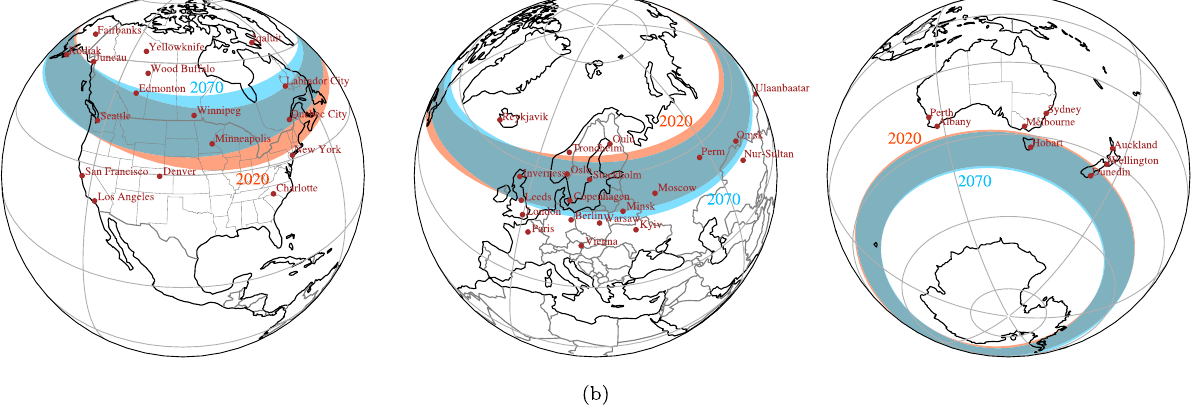
Figure 1. Auroral zones and danger zones for 2020 and 2070 for the mean MPG forecast. ( a ) Auroral zones for the 2020 (in red) and 2070 (in blue) epochs. The AACGM latitudes for the 2020 epoch are calculated from geomagnetic field coefficients given by the IGRF-13. For the 2070 epoch the AACGM coordinates were calculated from the mean MPG forecast. The red and blue diamonds indicate the location of the geomagnetic poles at 2020 and 2070, respectively. The red and blue triangles indicate the location of the magnetic dip poles at 2020 and 2070, respectively. ( b ) Near-side projection of the regions exposed to severe space weather events (‘danger zones’) for the 2020 (the orange bands) and 2070 (the cyan bands) epochs. The AACGM latitudes for the 2020 epoch are calculated from geomagnetic field coefficients given by the IGRF-13. For the 2070 epoch the AACGM coordinates were calculated from the mean MPG forecast. All maps were generated in Python 3.8 with the library cartopy (version